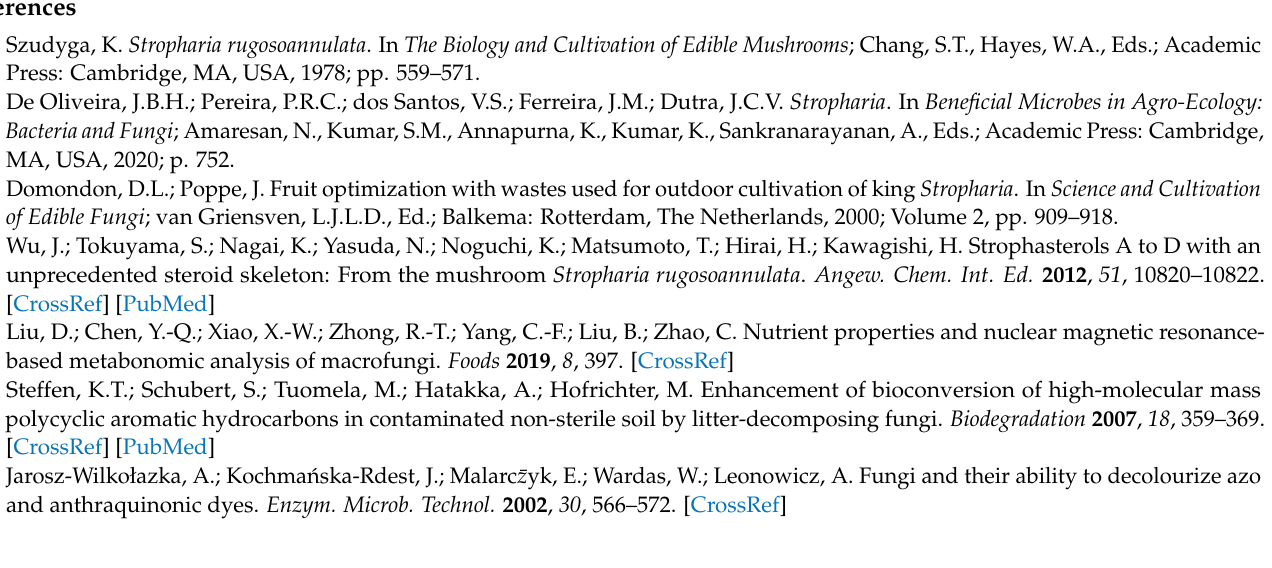
Table S6-3: Gene function annotation; Table S7: GO analysis of the secreted proteins; Table S8: Number of genes in a gene family; Table S9: Putative peroxidase-encoding genes of the 63 Agricomycotina [35]; Table S10: 17 MnP genes classification; Table S11: Putative peroxidase-encoding genes of Strophaira rugosoannulata ; Table S12: The number of CAZyme families in 16 species; Table S13-1: Comparative analysis of the plant cell wall degradation (PCWD) gene families with 37 fungi—cellulose; Table S13-2: Comparative analysis of the PCWD degradation (PCWD) gene families with 37 fungi—hemicellulose; Table S13-3: Comparative analysis of the PCWD gene families with 37 fungi—lignin and xenobiotics; Table S14-1: Variables Failing Tolerance Test; Table S14-2: Classification function coefficients resulting from discriminant analysis obtained from PCWD characters; Table S14-3: Classification results; Table S15: The gene clusters of Strophatria rugosoannulata predicted by antiSMASH; Table S16: The number of gene clusters predicted by antiSMASH; Table S17: NRPS gene cluster responsible for coprinoferrin in Coprinopsis cinerea , Stropharia rugosoannulata , and Hypholoma sublateritium ; Table S18: P450 genes involved in the xenobiotic metabolism of Stropaharia rugosoannulata